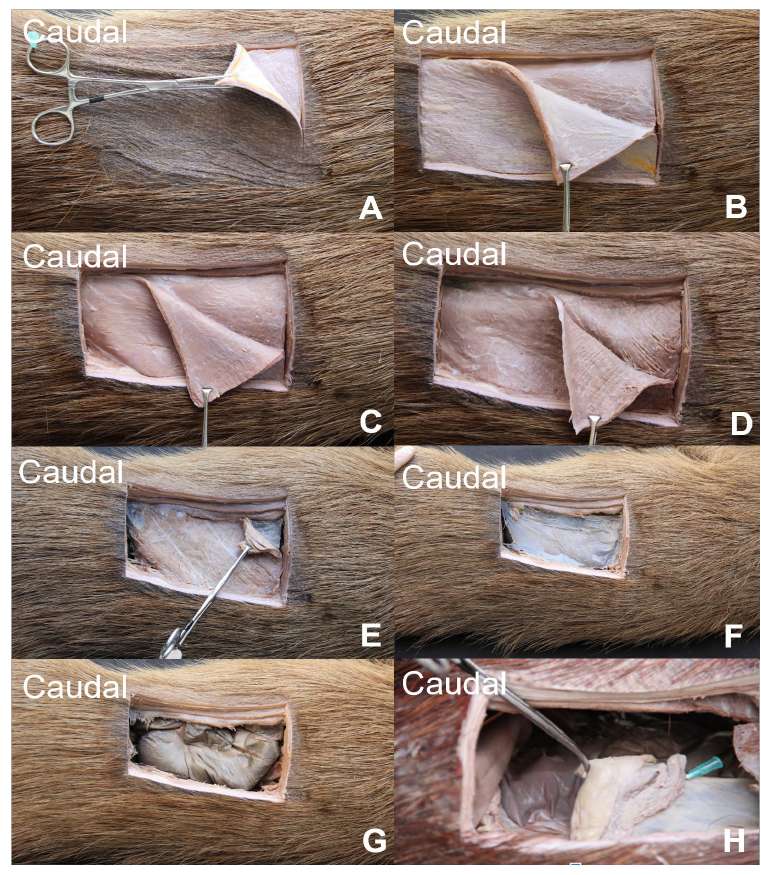
Figure 2. Dissection of left flank region between the last rib and iliac crest; caudal to the left. ( A ) Skin; ( B ) cutaneous muscle being deflected; ( C ) external abdominal oblique muscle being deflected, exposing the internal abdominal oblique muscle; ( D ) internal abdominal oblique muscle being deflected exposing the transversus abdominis muscle; ( E ) transversus abdominis muscle being deflected exposing the parietal peritoneum ( F ); ( G ) cecum covering the ovary and uterine tube; and ( H ) uterine tube and mesosalpinx (green needle).